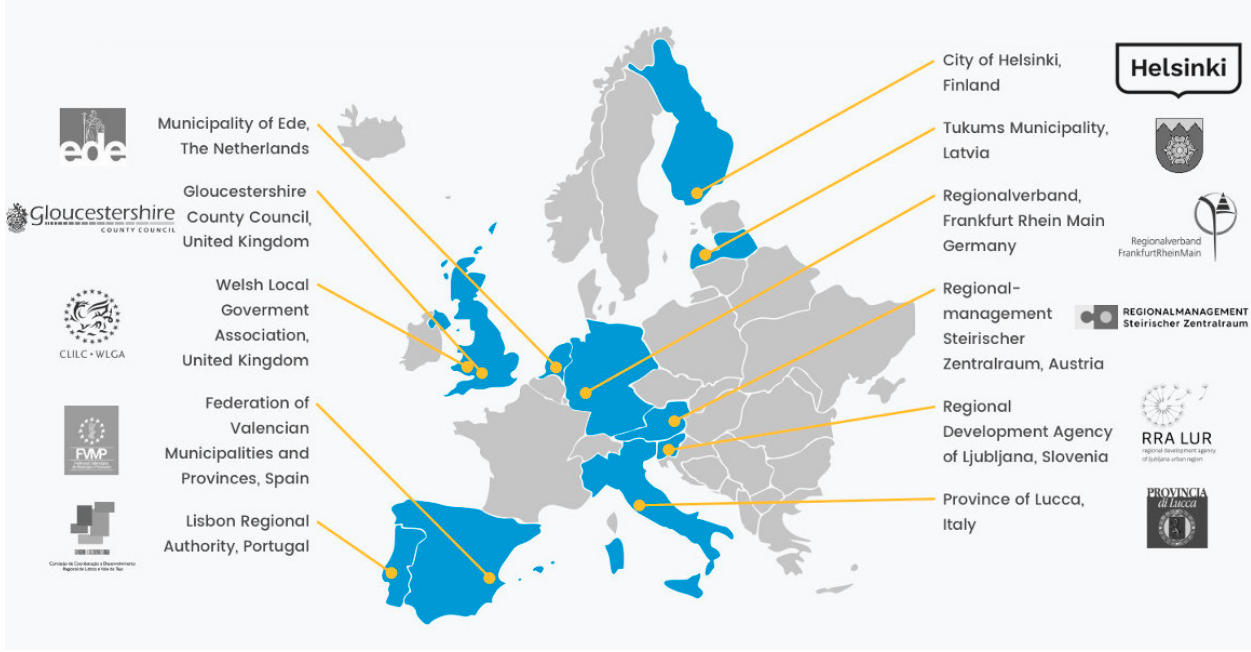
Figure 1. ROBUST consortium partners leading the project’s 11 Living